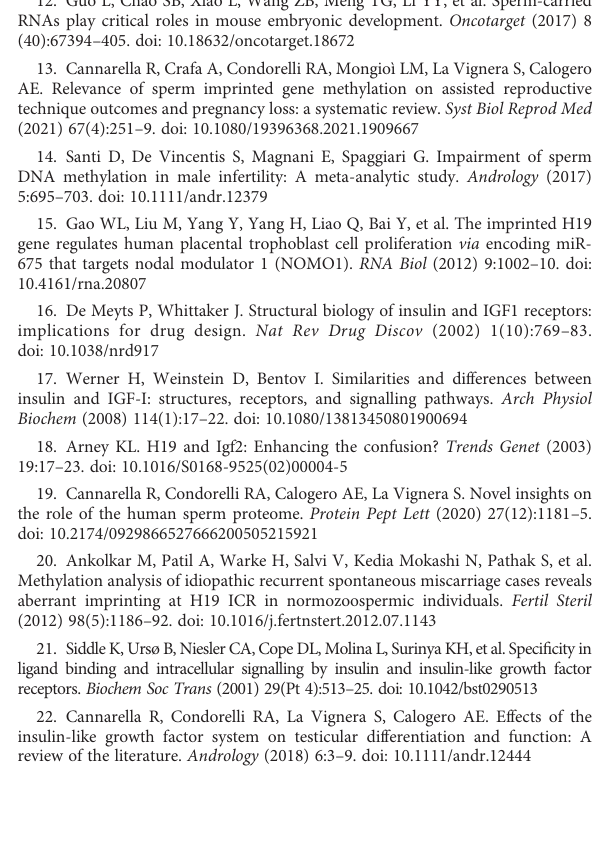
SUPPLEMENTARY FIGURE 1 FSHR protein expression in HT29 cells. The immuno fl uorescence analysis of the FSHR protein expression in HT29 cell lines, used as negative control, shows no expression. Blu: DAPI (nuclei), Green: dy-light 488. Magni fi cation 100x. SUPPLEMENTARY FIGURE 2 Dot plots of FSHR-positive porcine SCs. SCs (A) . SCs + NVP-AEW541 (B) . SCs + IGF2 0.3 ng/ml (C) . SCs + IGF2 0.3 ng/ml + NVP-AEW541 (D) . SCs + IGF2 + 3 ng/ml (E) . SCs + IGF2 + 3 ng/ml + NVP-AEW541 (F) . SCs + IGF2 10 ng/ml (G) . SCs + IGF2 10 ng/ml + NVP-AEW541 (H) . Each dot plot is representative of 3 independent experiments. In each box, the histogram on the left is the same sample without the antibody for FSHR SUPPLEMENTARY FIGURE 3 Histogram of CFSE-positive porcine SCs quanti fi ed by fl ow cytometry. SCs (A) . SCs + NVP-AEW541 (B) . SCs + IGF2 0.3 ng/ml (C) . SCs + IGF2 0.3 ng/ml + NVP-AEW541 (D) . SCs + IGF2 + 3 ng/ml (E) . SCs + IGF2 + 3 ng/ml + NVP-AEW541 (F) . SCs + IGF2 10 ng/ml (G) . SCs + IGF2 10 ng/ml + NVP- AEW541 (H) . Each histogram is representative of 3 independent experiments. In each box, the histogram on the left is the same sample unstained for